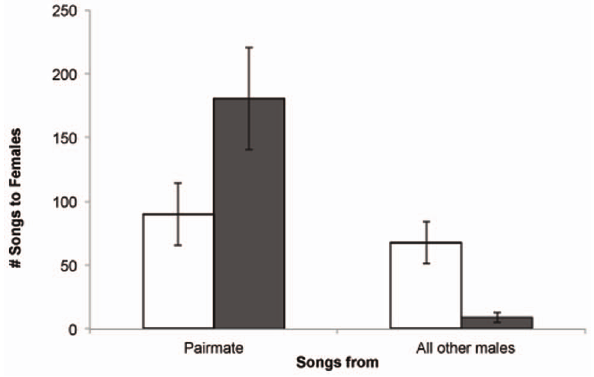
Figure 3. Lesioned females fail to pair-bond normally. Selectivity of directed singing by males to lesioned (open bars) and sham-lesioned (filled bars) females in experiment 2. Bars represent mean ( 6 1 SEM) songs received from the pair-mate and from all other males for 7 lesioned and 8 sham-lesioned females.